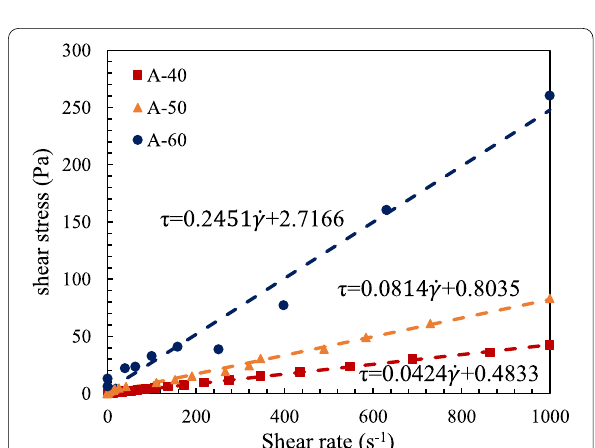
Fig. 9 Relationship between shear rate and shear stress of the studied